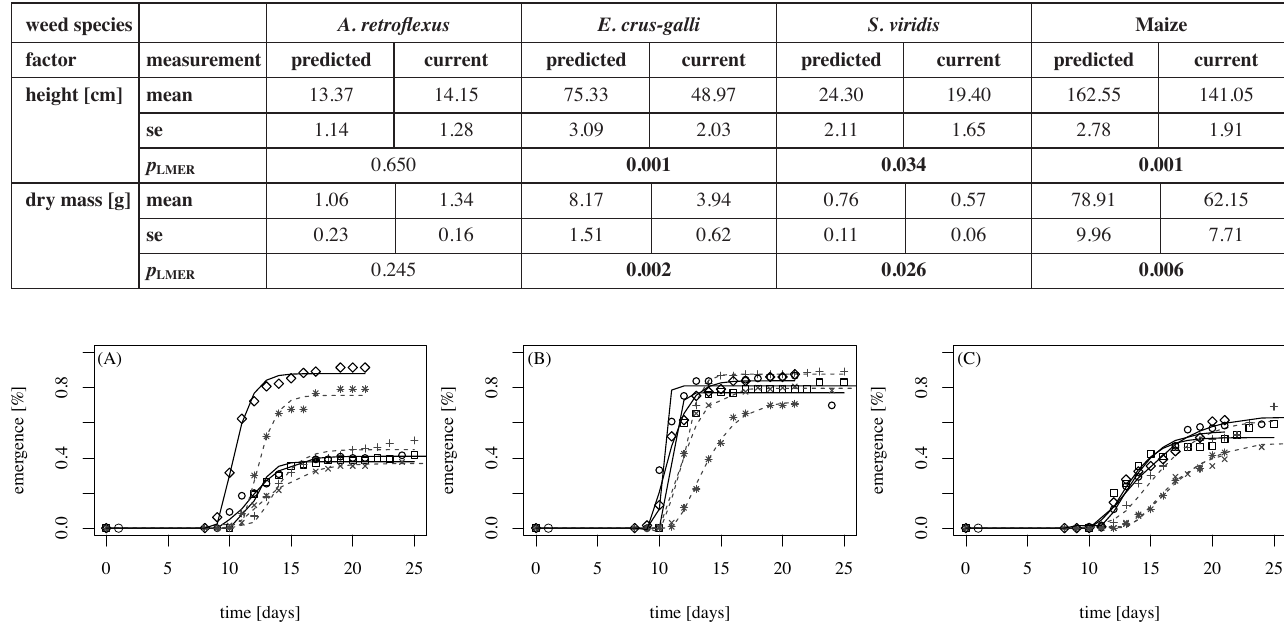
Fig. 2: Cumulated emergence of weed seeds over time for (A) Amaranthus retroflexus , (B) Echinochloa crus-galli , (C) Setaria viridis for the three replica- tions; square, diamond and circles mark readings in the climate chamber with predicted future conditions; +, x and * mark readings in the climate chamber with normal conditions; normal lines represent fitted curves under predicted future climate, dashed lines represent fitted curves under current